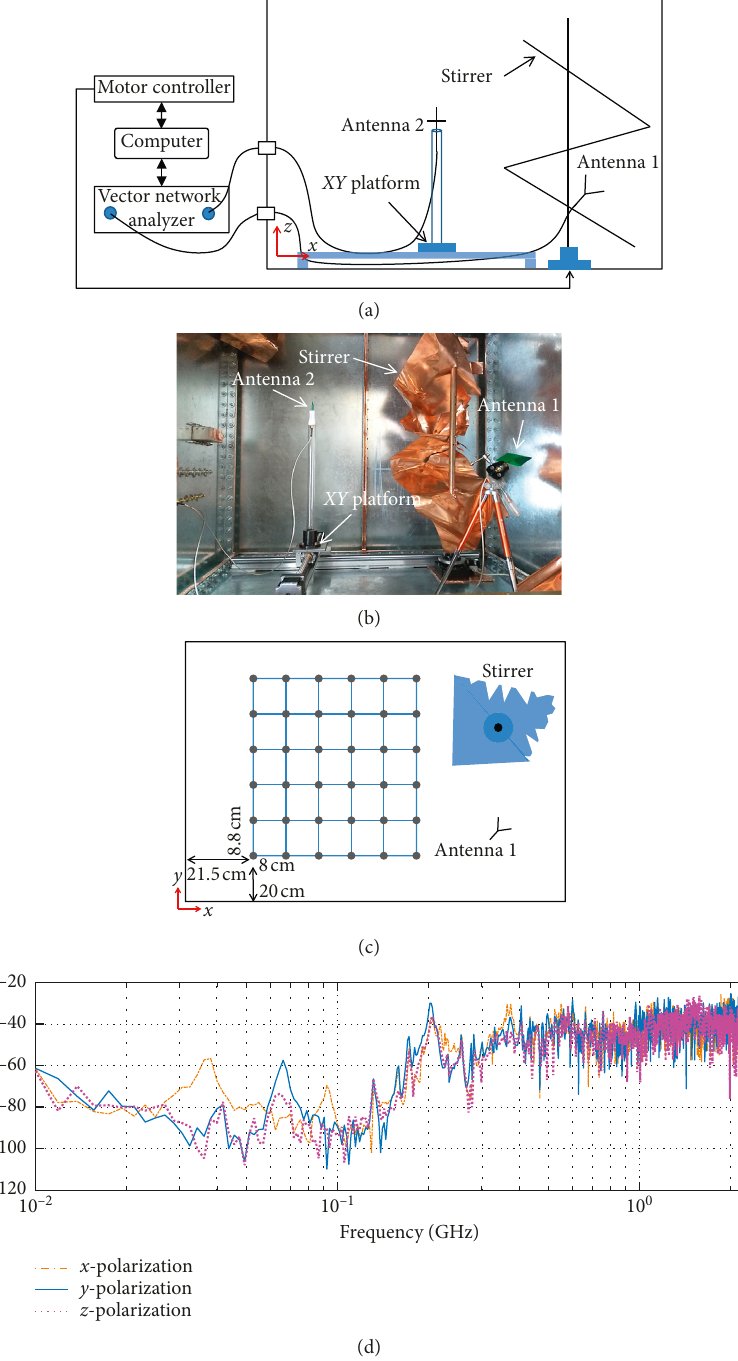
Figure 1: (a) Schematic plot of the measurement. (b) Measurement scenario: the dimensions of the RC are 0.8m × 1.2m × 1.2m; a plastic tube is used to support antenna 2. (c) Measurement positions of antenna 2 in the XY plane, and three different heights were measured: 30cm, 62cm, and 98 cm. (d) Typical measured S at one probe position with three 21